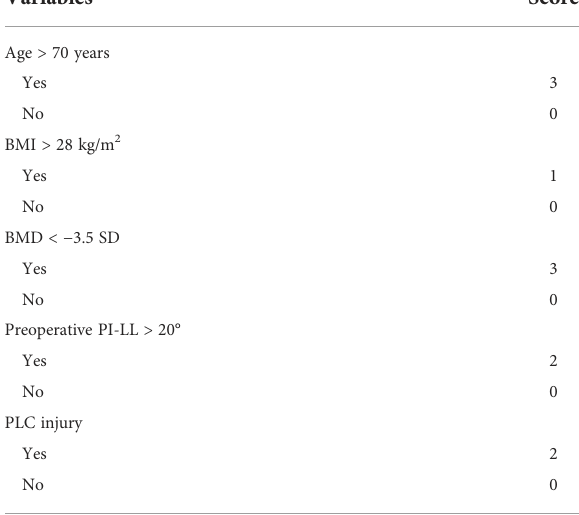
TABLE 3 The scoring system for predicting postoperative PJK.